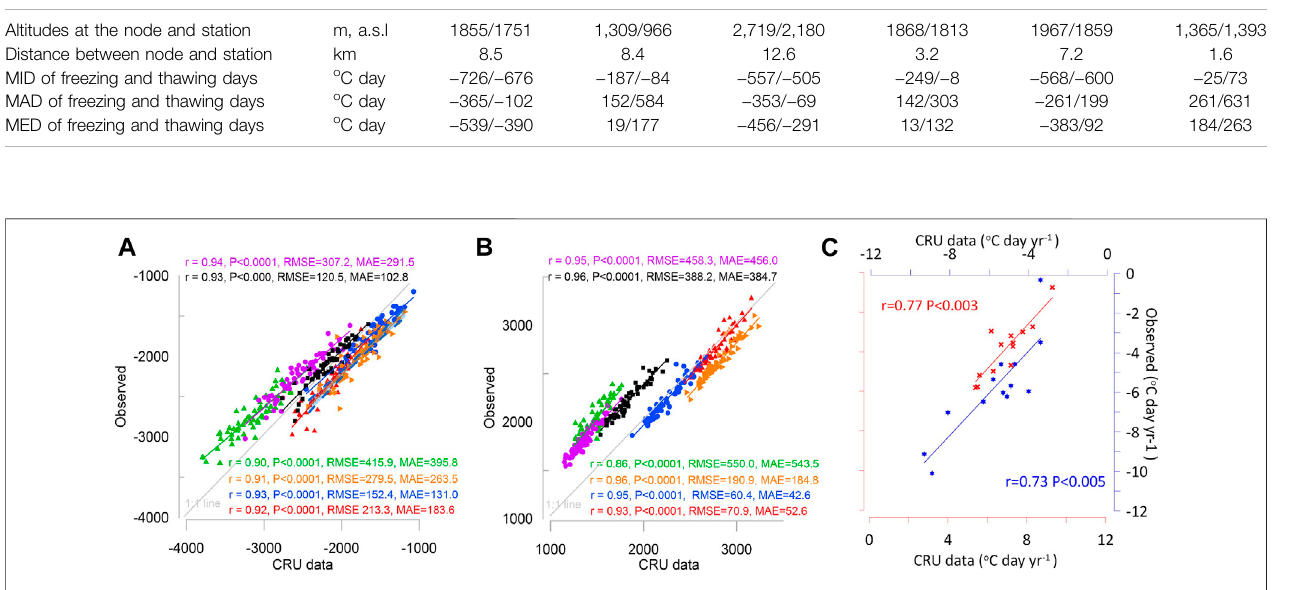
TABLE 2 | Difference in selected variables between the node (i.e. grid center) and meteorological stations at the six comparison sites. Note: MID (cid:2) minimum difference; MAD (cid:2) maximum difference; MED (cid:2) mean difference. The slash represents the CRU data in front and the station in behind. Variable Altitudes at the node and station